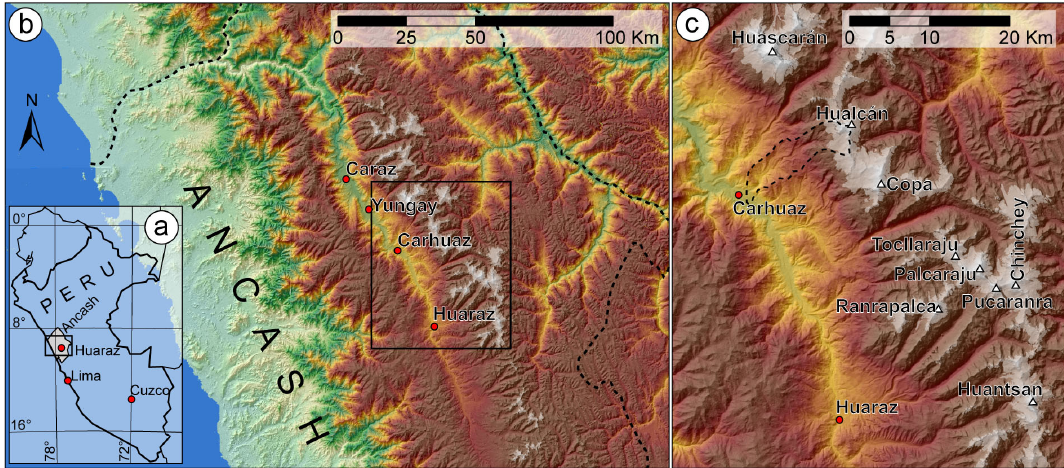
Fig. 1. (a) Location of province of Ancash (gray) in Peru. (b) Overview of the Cordillera Blanca (gray) within Ancash (dashed line). (c) Detail of the Cordillera Blanca with the cities of Huaraz and Carhuaz and the Río Chucchun river catchment as the main study site (dashed line). Gray areas indicate the glaciers in the year 2003 and the triangles show peaks > 6000ma.s.l. and the corresponding names. Rectangles correspond to the extents of the sub-images and background image is a colored hillshade relief derived from ASTER GDEM2 data.